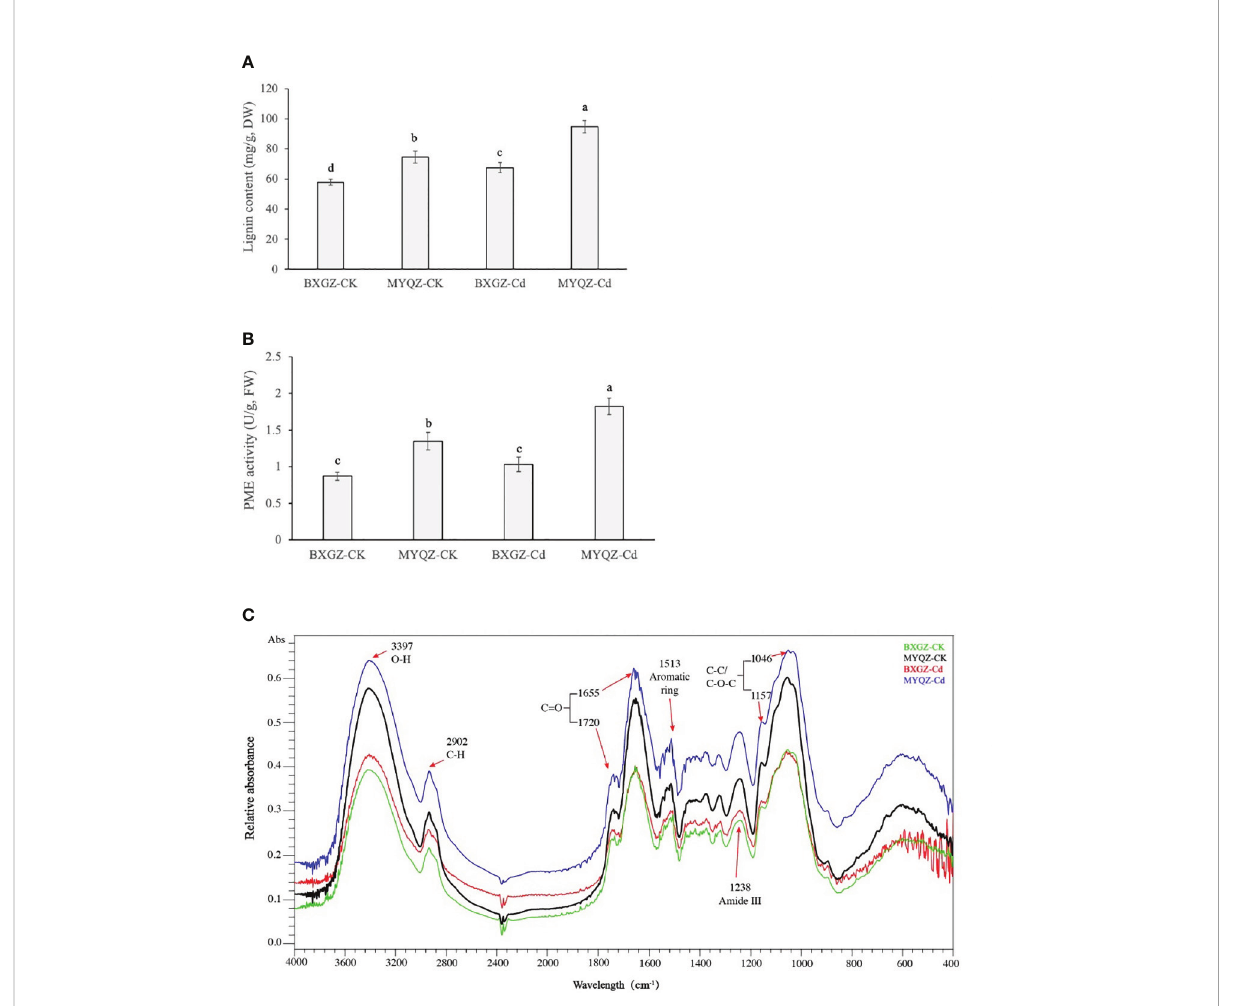
FIGURE 6 The lignin contents (A) , PME activities (B) and FTIR spectral analysis (C) of BXGZ and MYQZ under different treatments. Values are the mean ± standard error (n = 3). Different small letters indicate signi fi cant differences ( p < 0.05) among the four